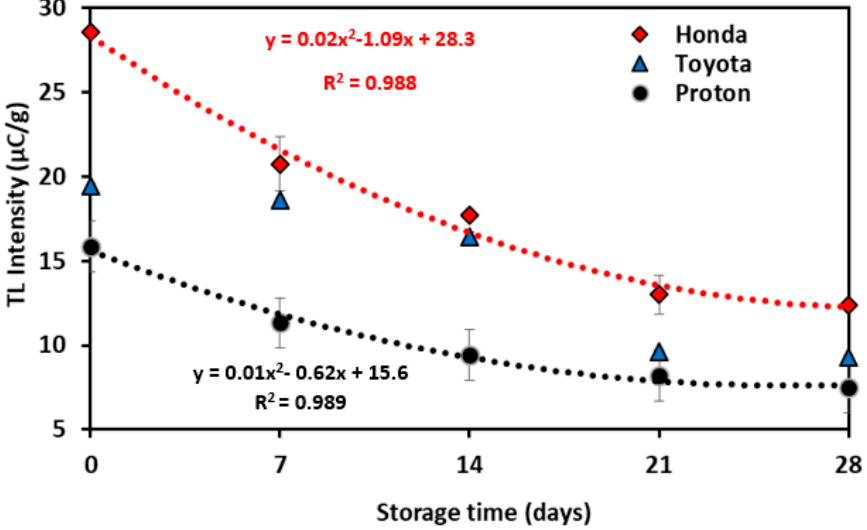
Figure 7. Long-term fading of the TL signal, noting that during periods other than readout the samples are stored in the dark at ambient temperature (27 °C).